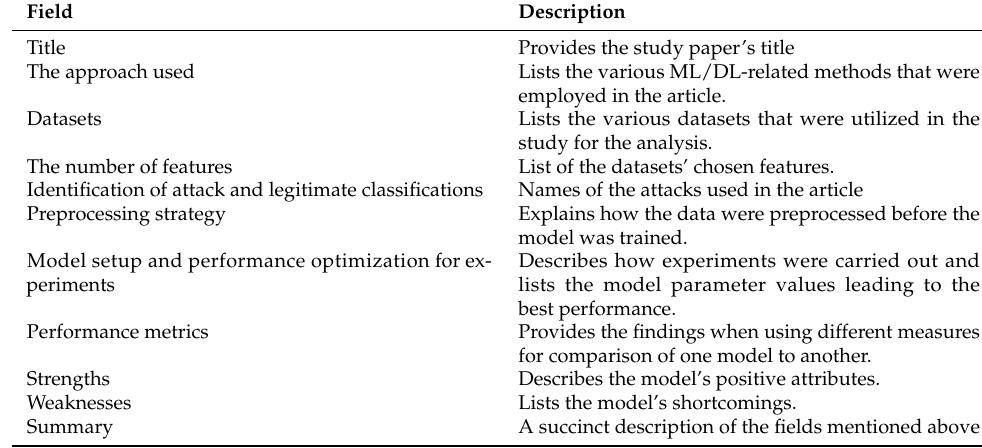
Table 2. Fields used for data